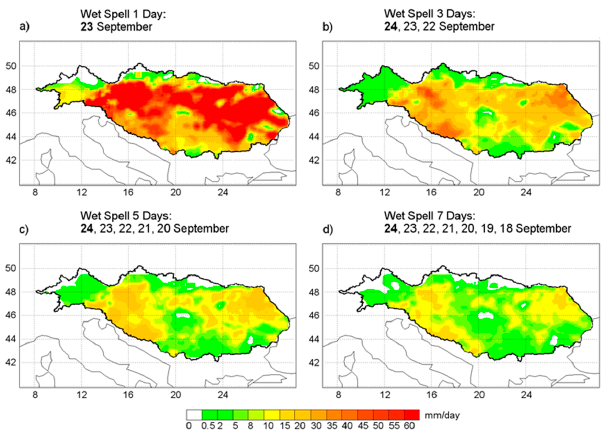
Figure 3. Mean daily values of precipitation anomalies (shaded, mm/day) for wet spell event of 23 September 1996 in duration of one, three, five and seven days, on the area of the DRB (Danube River Basin). Daily data from CHIRPS in a 0.05° degree spatial resolution in latitude and longitude.